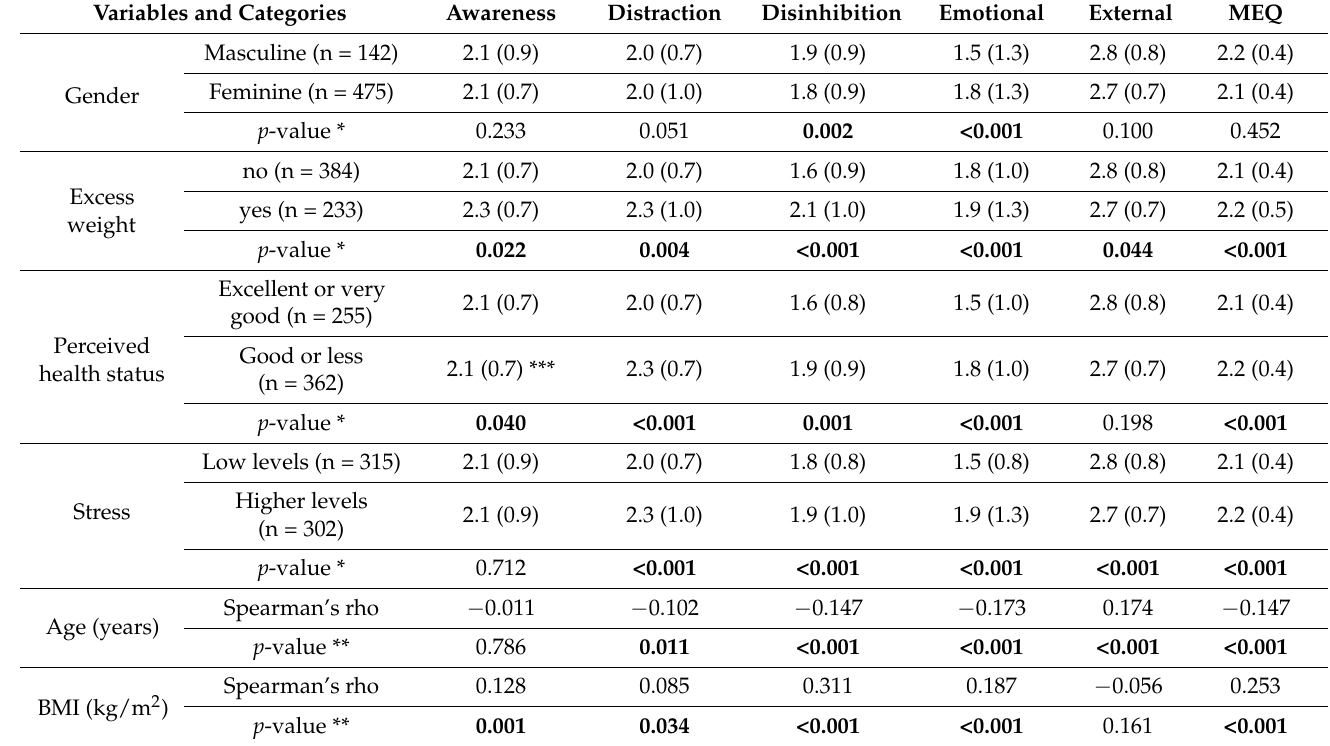
Table 4. MEQ score and subscales score per demographic variables (n =